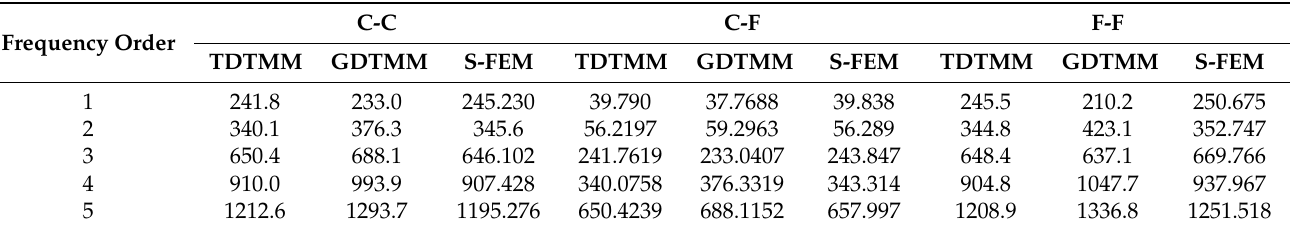
Table 3. Natural frequencies (Hz) for the beam of example 1 with three boundary conditions (C-C, C-F, F-F) obtained by TDTMM, GDTMM and S-FEM.